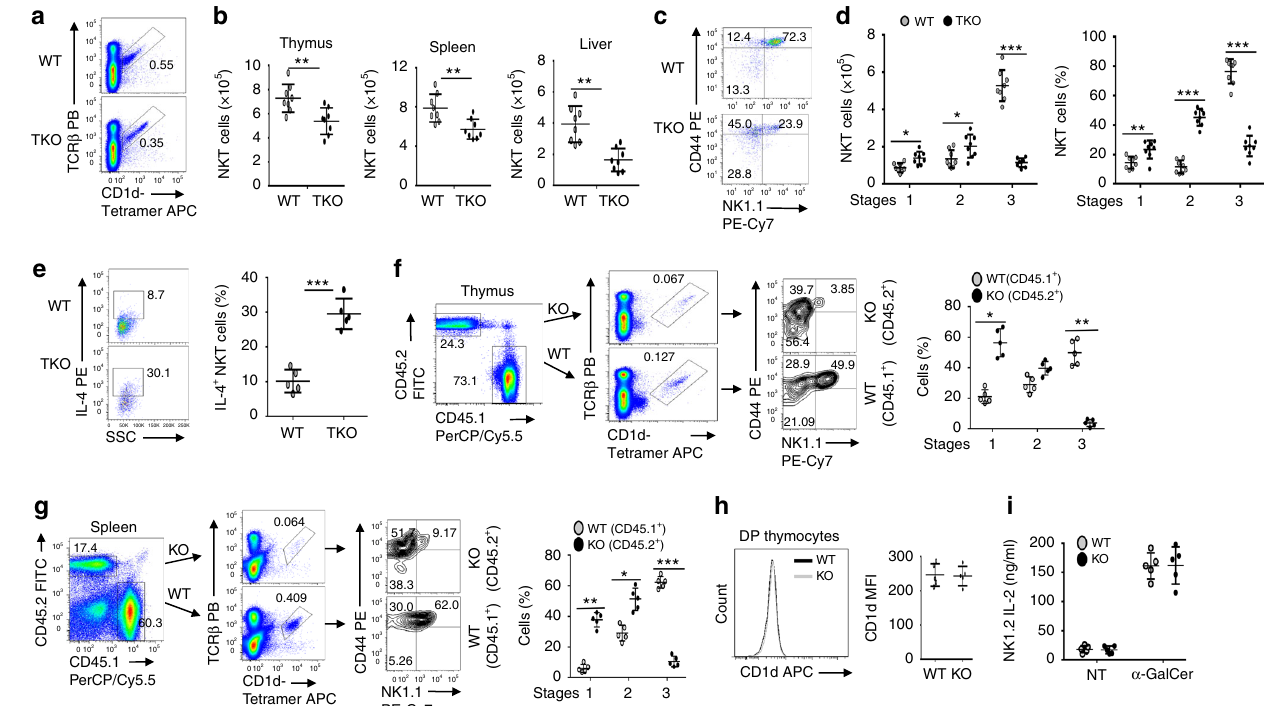
Fig. 2 Tbkbp1 has a cell-intrinsic role in regulating NKT cell development. a , b Flow cytometric analysis of NKT cells in the thymus, spleen, and liver from